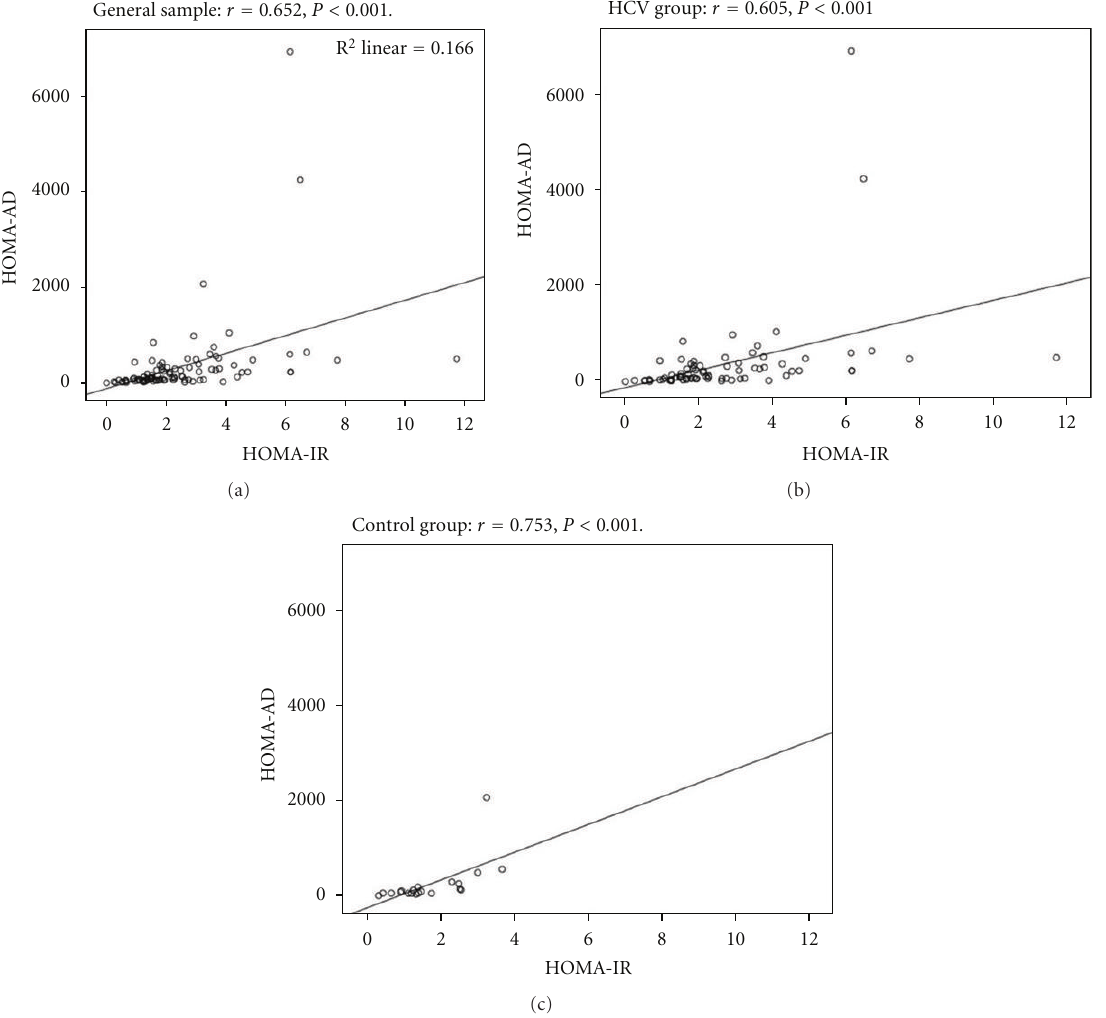
Figure 1: Spearman’s correlation coe ffi cient between HOMA-IR and HOMA-AD in the general sample, HCV, and control